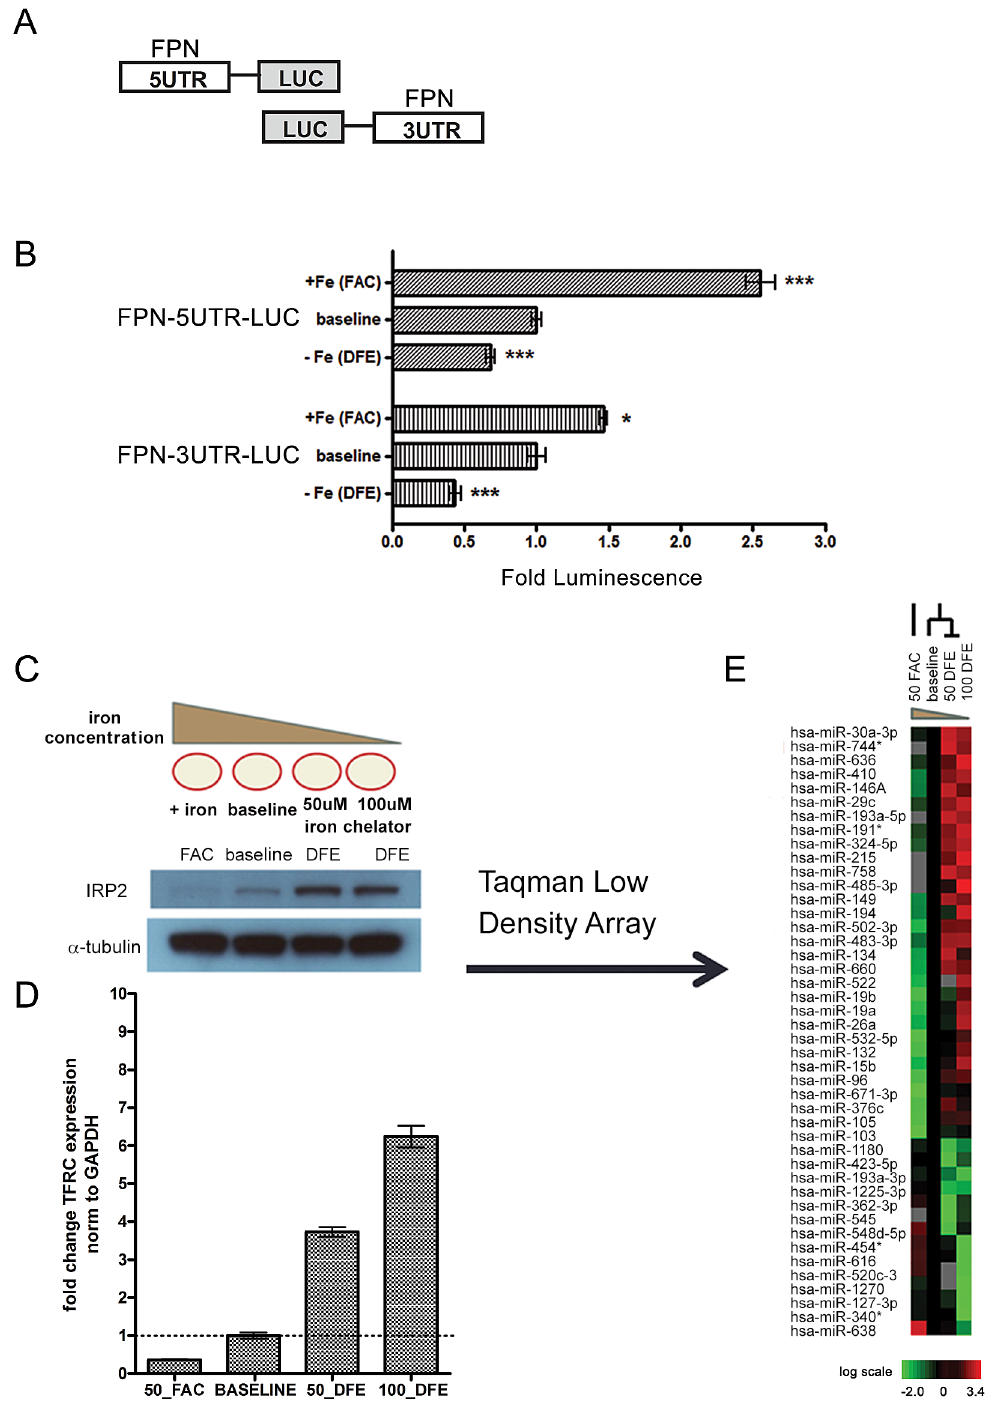
Figure 1. Ferroportin is post-transcriptionally regulated by elements within both the 5 9 and 3 9 UTRs in response to altered cellular iron concentration. (A) Schematic of FPN-5 9 UTR and FPN-3 9 UTR luciferase reporters. (B) The FPN 5 9 UTR and 3 9 UTR luciferase reporter constructs were transfected in HepG2 cells and treated with conditions of iron-supplementation (FAC) or iron-depletion (DFE). The relative luciferase activities following iron-supplementation (FAC) or iron-depletion (DFE) are shown when compared with baseline condition. Data is expressed as fold change in luminescence 6 SEM relative to baseline condition, normalized to empty reporter control (n=3). (C) Schematic of iron-supplementation (FAC) or iron- depletion (DFE) of K562 cells to achieve iron-rich and iron-deficient conditions and western blot analysis of IRP2 protein levels in the corresponding conditions. (D) QRT-PCR analysis of TFRC expression from corresponding samples shown in (C), normalized to GAPDH control. (E) Heatmap representation of microRNA expression in cells treated as indicated in (C). The heatmap indicated the change of Ct obtained by the RQ Manager v1.2 which has been normalized to RNU48 endogenous control. MicroRNAs with a log2 expression change of at least 0.5 in either the iron-rich or iron- deficient condition when compared to baseline were selected and considered to be iron-responsive. These microRNAs are filtered and arranged by hierarchical clustering as shown. * Significantly different by Student’s t-test: *p , 0.05, ***p , 0.0001. doi:10.1371/journal.pgen.1003408.g001 PLOS Genetics | www.plosgenetics.org 3 April 2013 | Volume 9 | Issue 4 |